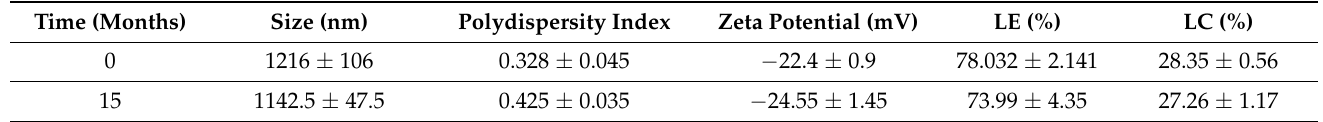
Table 1. The size, polydispersity index, zeta potential, loading efficiency, and loading capacity of freshly synthesized LON and after 15 months’ storage at − 20 °C.